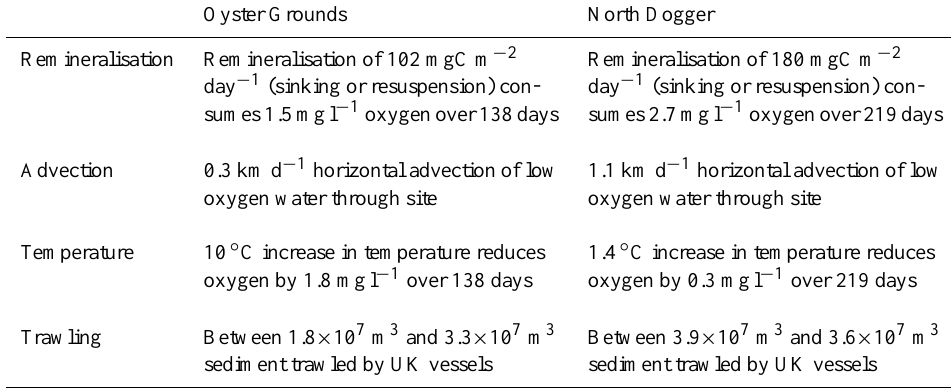
Table 8. Summary of the processes controlling the dissolved oxygen concentration at Oyster Grounds and North